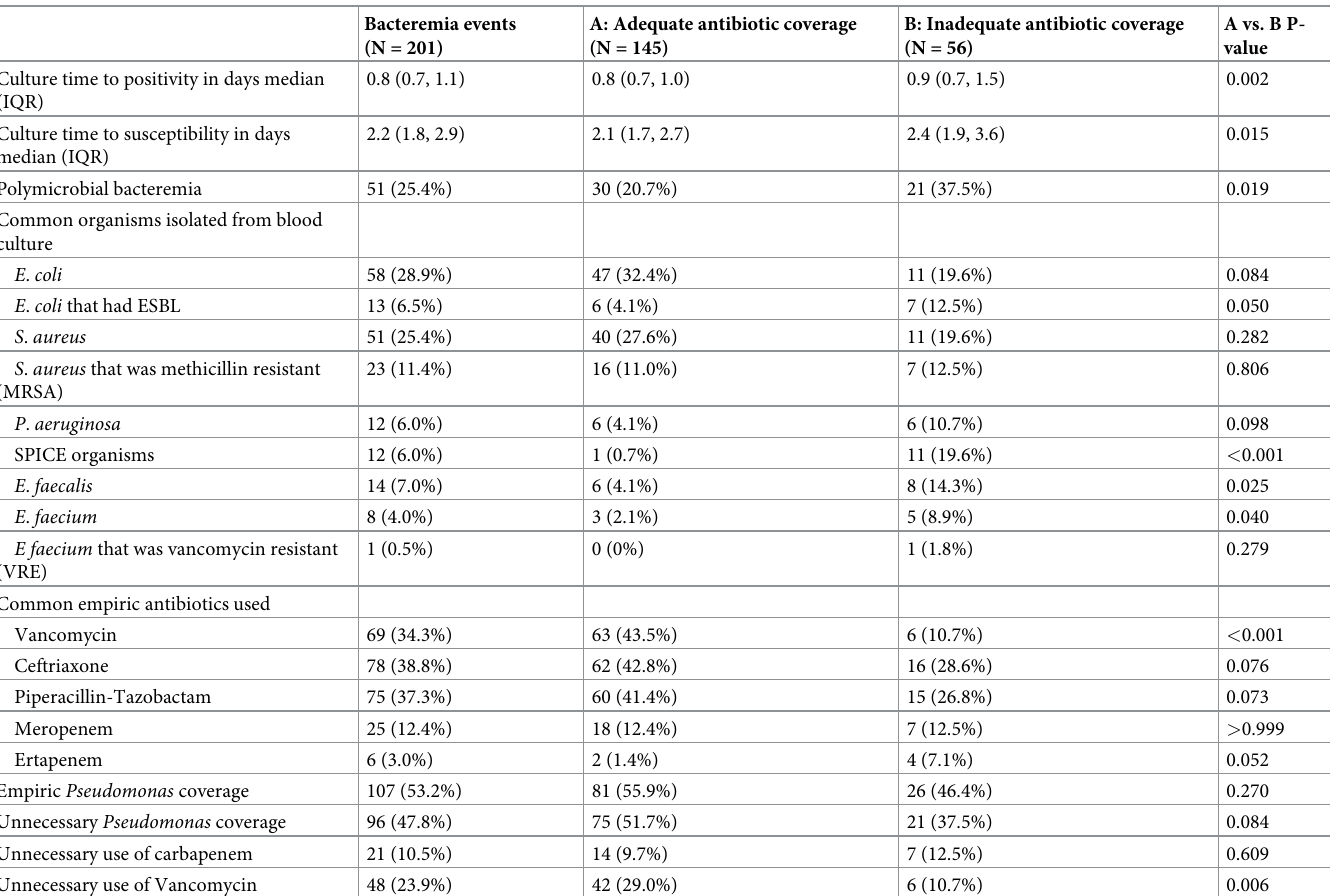
Table 3. Blood culture results and empiric antibiotic